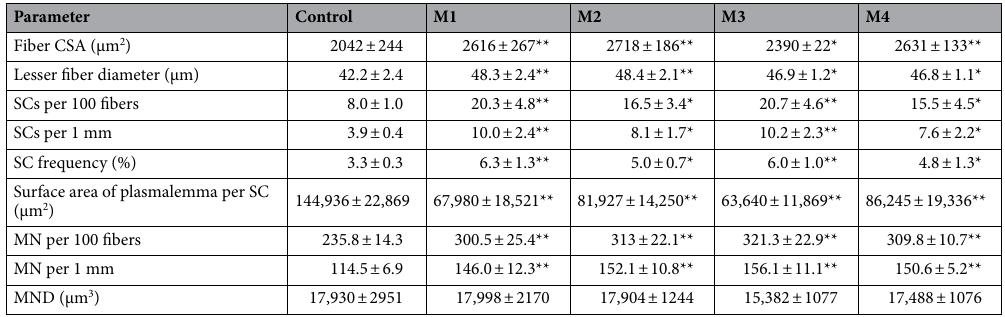
Table 2. Pectoralis major fiber size and cellular parameters in control and mesterolone-treated groups. M1, M2, M3, M4: groups treated with 4, 8, 12, and 16 mg/kg mesterolone, respectively. CSA: cross-sectional area; SC: satellite cell; MN: myonuclei; MND: myonuclear domain. Values represent the means ± standard deviations. * P < 0.05, ** P < 0.01 significantly different from the control group (ANOVA, LSD post-hoc ).